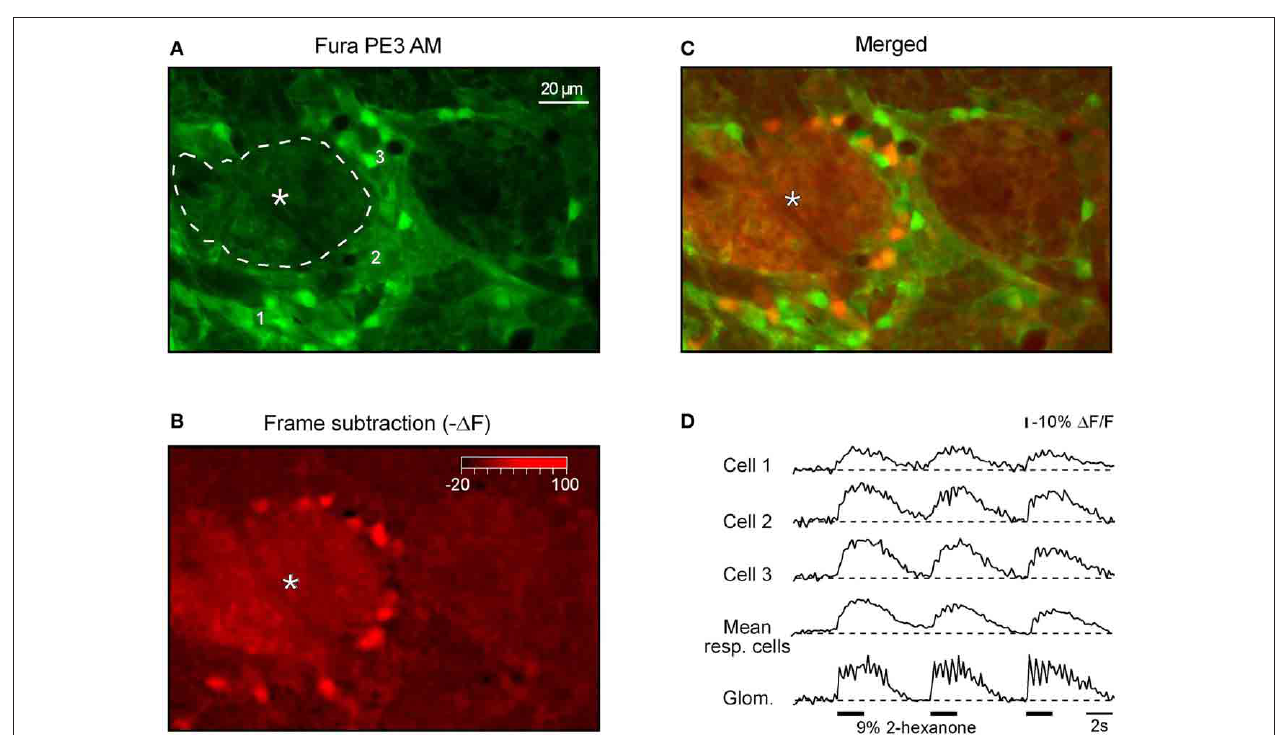
FIGURE 7 | Response type consistency as a functionof odorant concentration.(A,B) (cid:2) F/F traces recorded from two neurons marked with numbers in (A) (as indicated) at different odorant concentrations. Cell 1